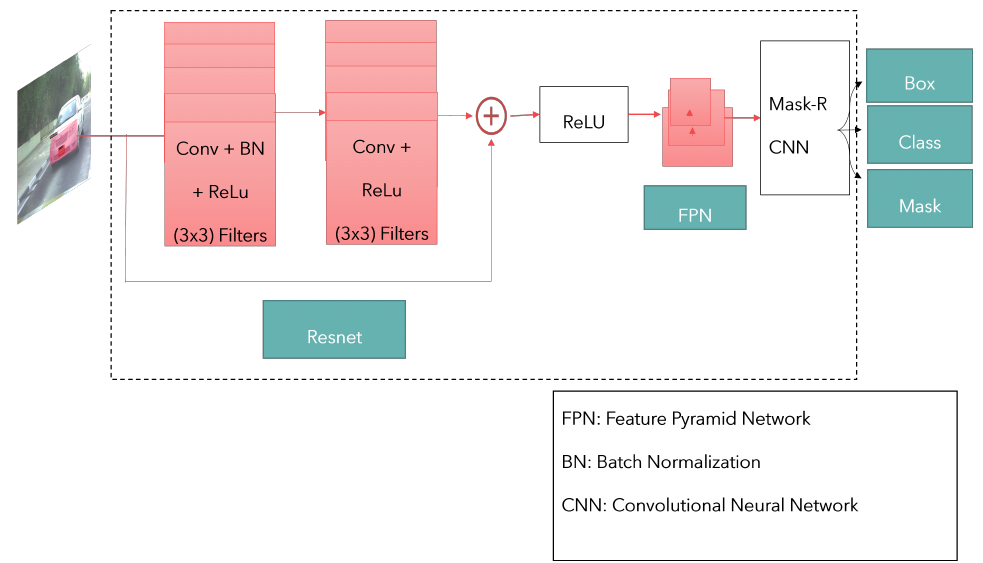
Figure 3. The maskRCNN with FPN